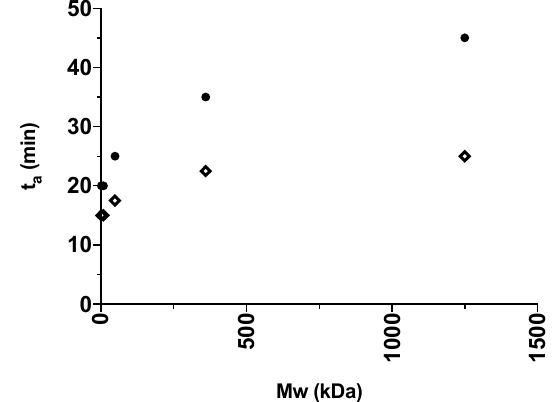
Figure 4. The t a (min) of the different IND:PVP 50:50 w/w (diamond) and CAP:PVP 50:50 w/w (circle) mixtures plotted against the average M w (kDa) of the polymer grade in the certain mixture.